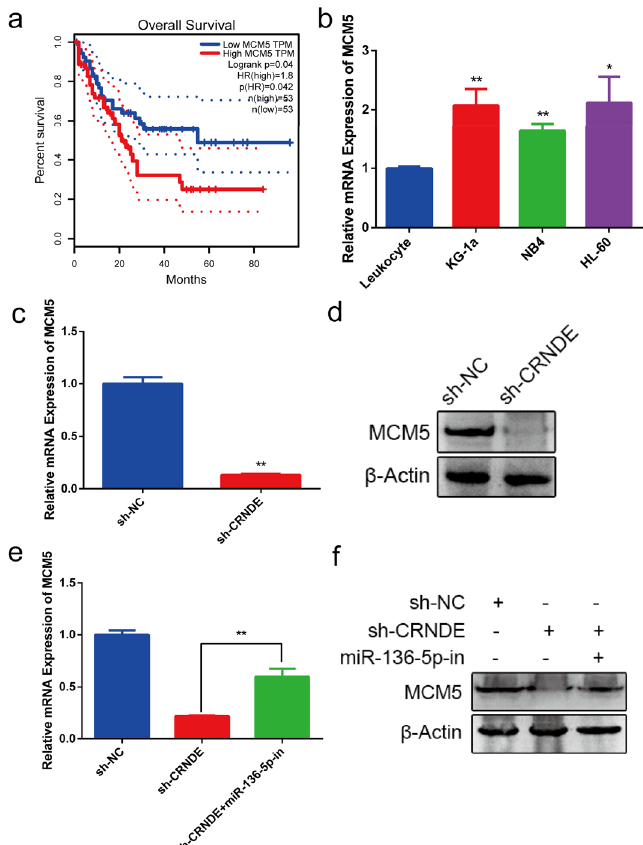
Figure 6. CRNDE regulates MCM5 through sponging miR-136-5p. ( a ) The overall survival curves of MCM5 in AML patients from GEPIA analysis. ( b ) MCM5 expression in AML cell lines was detected by qRT-PCR. ( c ) QRT-PCR assay was used to detect the expression of MCM5 mRNA after knocking down CRNDE. ( d ) Western blot was used to detect the expression of MCM5 protein after knocking down CRNDE. ( e , f ) Rescue assay was performed to verify that the effects could be reversed by miR-136-5p inhibitors at both mRNA and protein levels. * p < 0.05, ** p < 0.01.